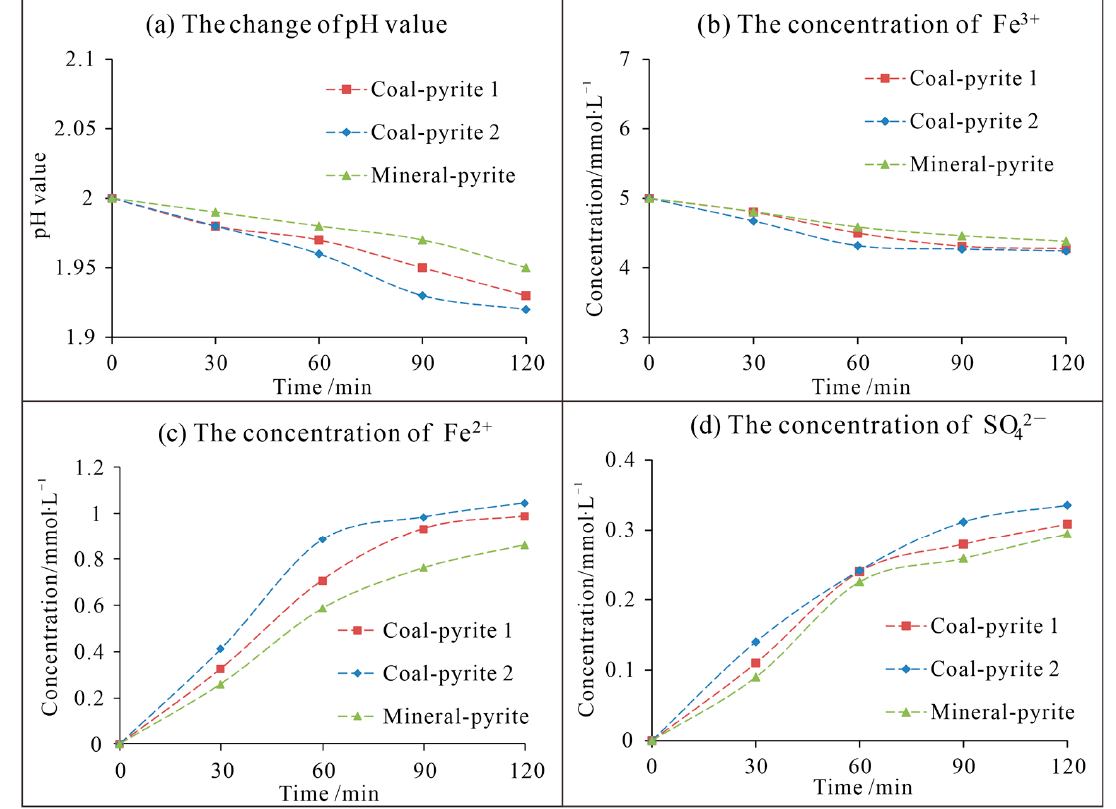
Figure 6. The change of pH value and component concentration in reaction solution with Fe 3+ : ( a ) is the change of pH value; ( b ) is the change of Fe 3+ concentration; ( c ) is the change of Fe 2+ concentration; ( d ) is the change of SO 42 − concentration.